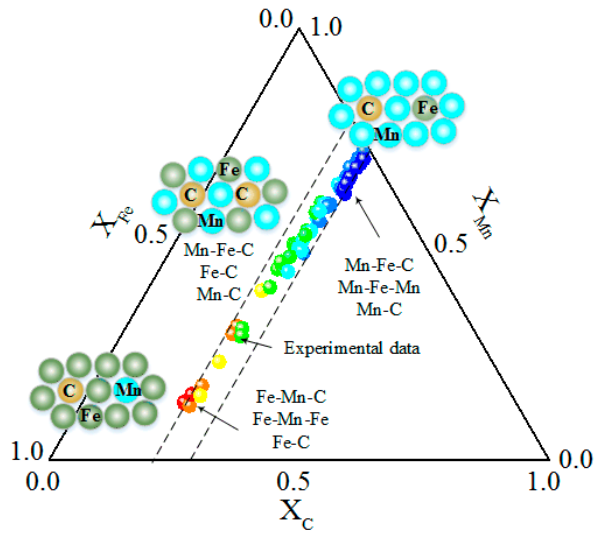
Figure 7. Environment of each atom in Mn-Fe-C liquid alloys determined from MIVM modeling of the ternary alloys.